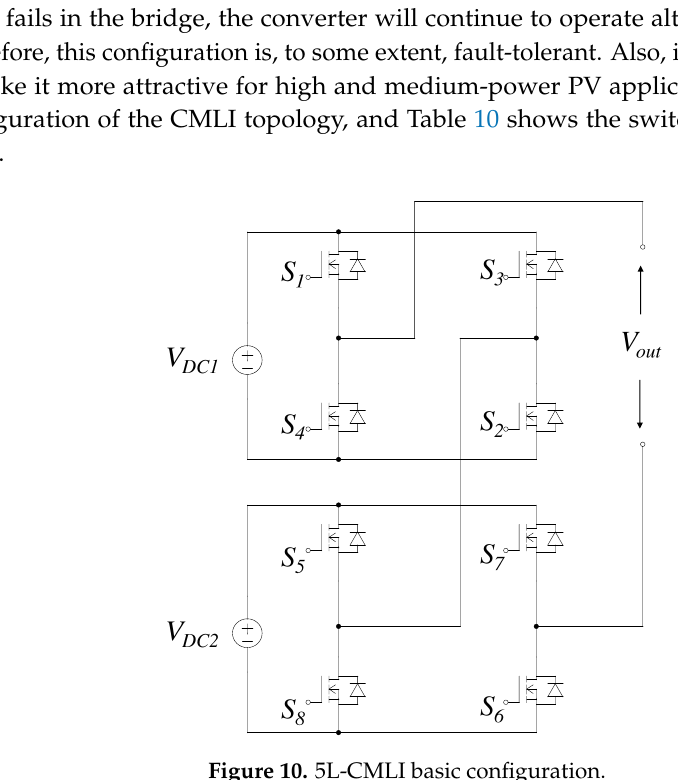
Figure 10. 5L-CMLI basic